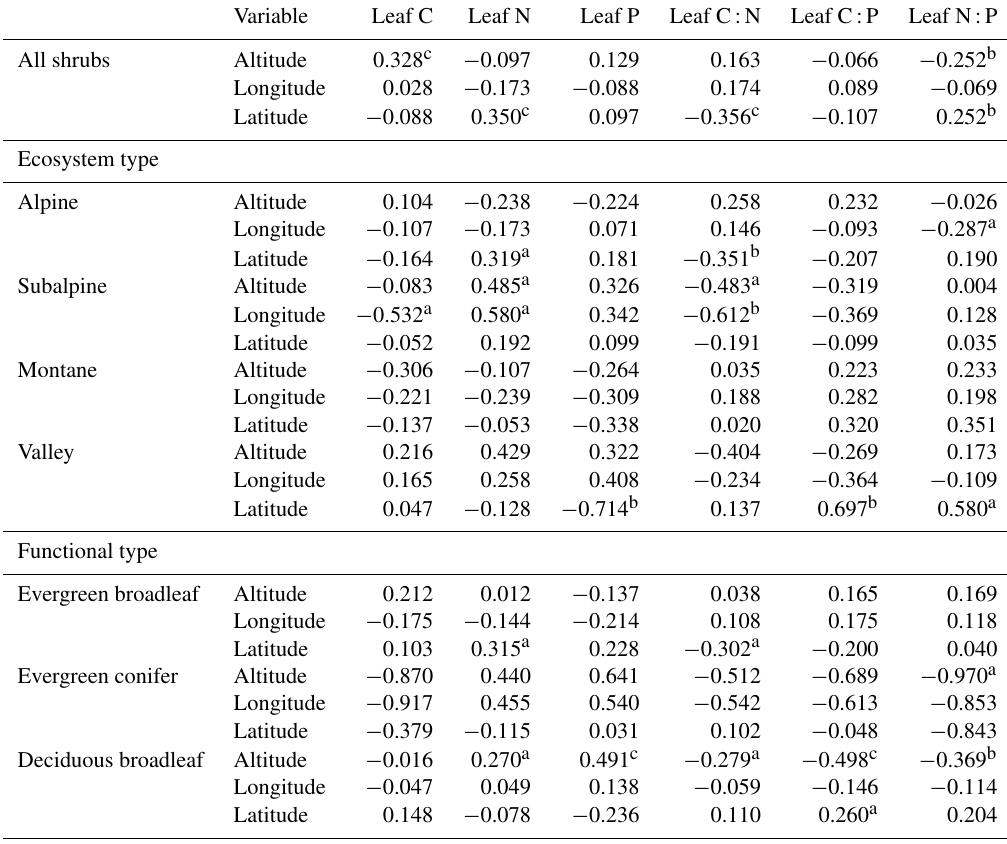
Table A3. Partial correlation coefficients between the geographic variables and leaf stoichiometry of all shrubs and different shrub types. Variable Leaf C Leaf N Leaf P Leaf C:N Leaf C:P Leaf N:P All shrubs Altitude 0.328 c − 0.097 0.129 0.163 − 0.066 − 0.252 b Longitude 0.028 − 0.173 − 0.088 0.174 0.089 − 0.069 Latitude − 0.088 0.350 c 0.097 − 0.356 c − 0.107